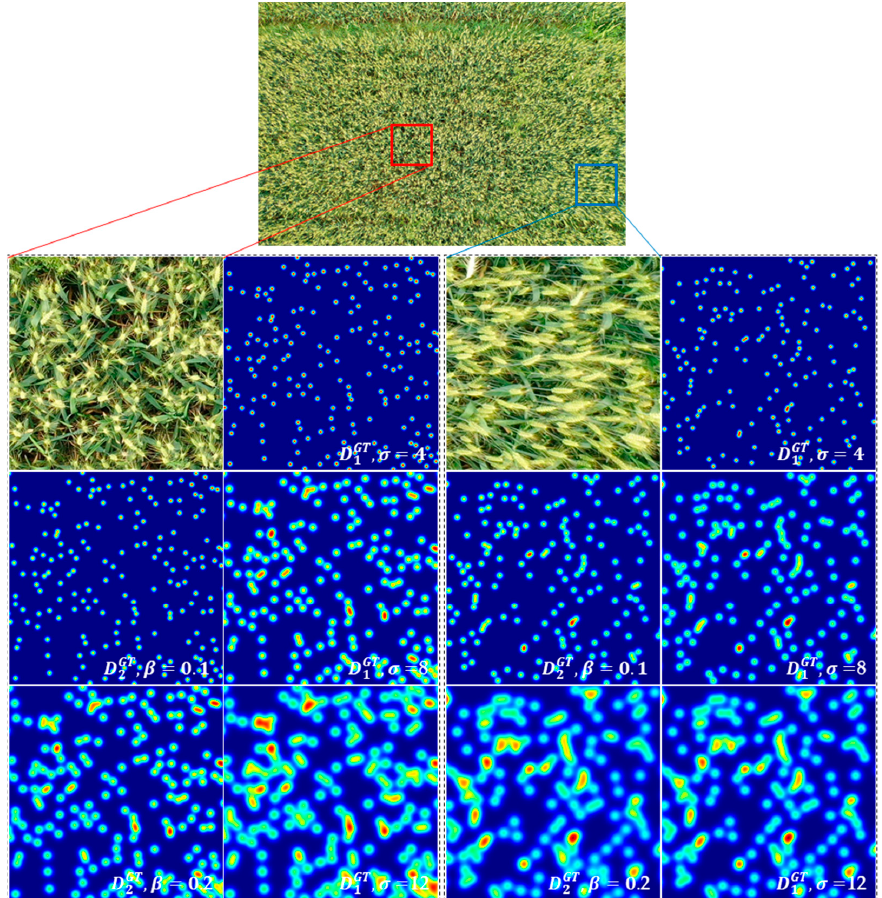
Figure 6. Density maps with different Gaussian